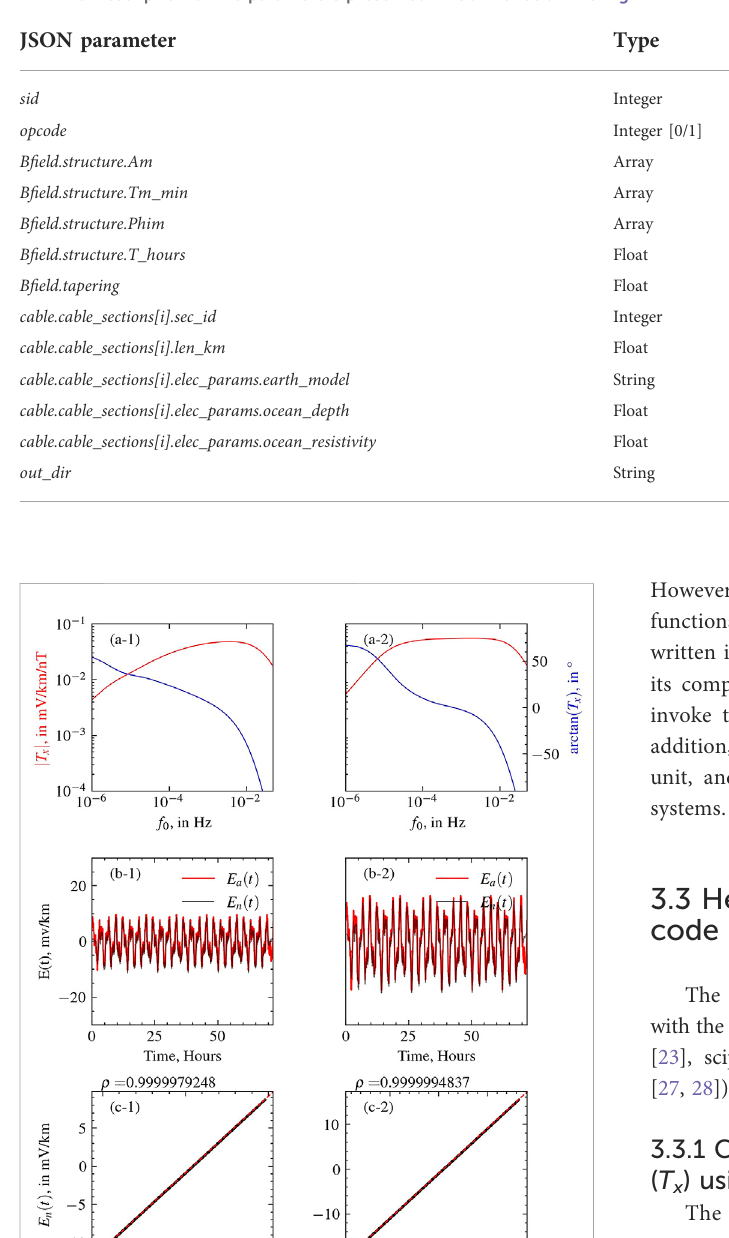
TABLE 5 Description of the parameters presented in Control JSON Listing 1.